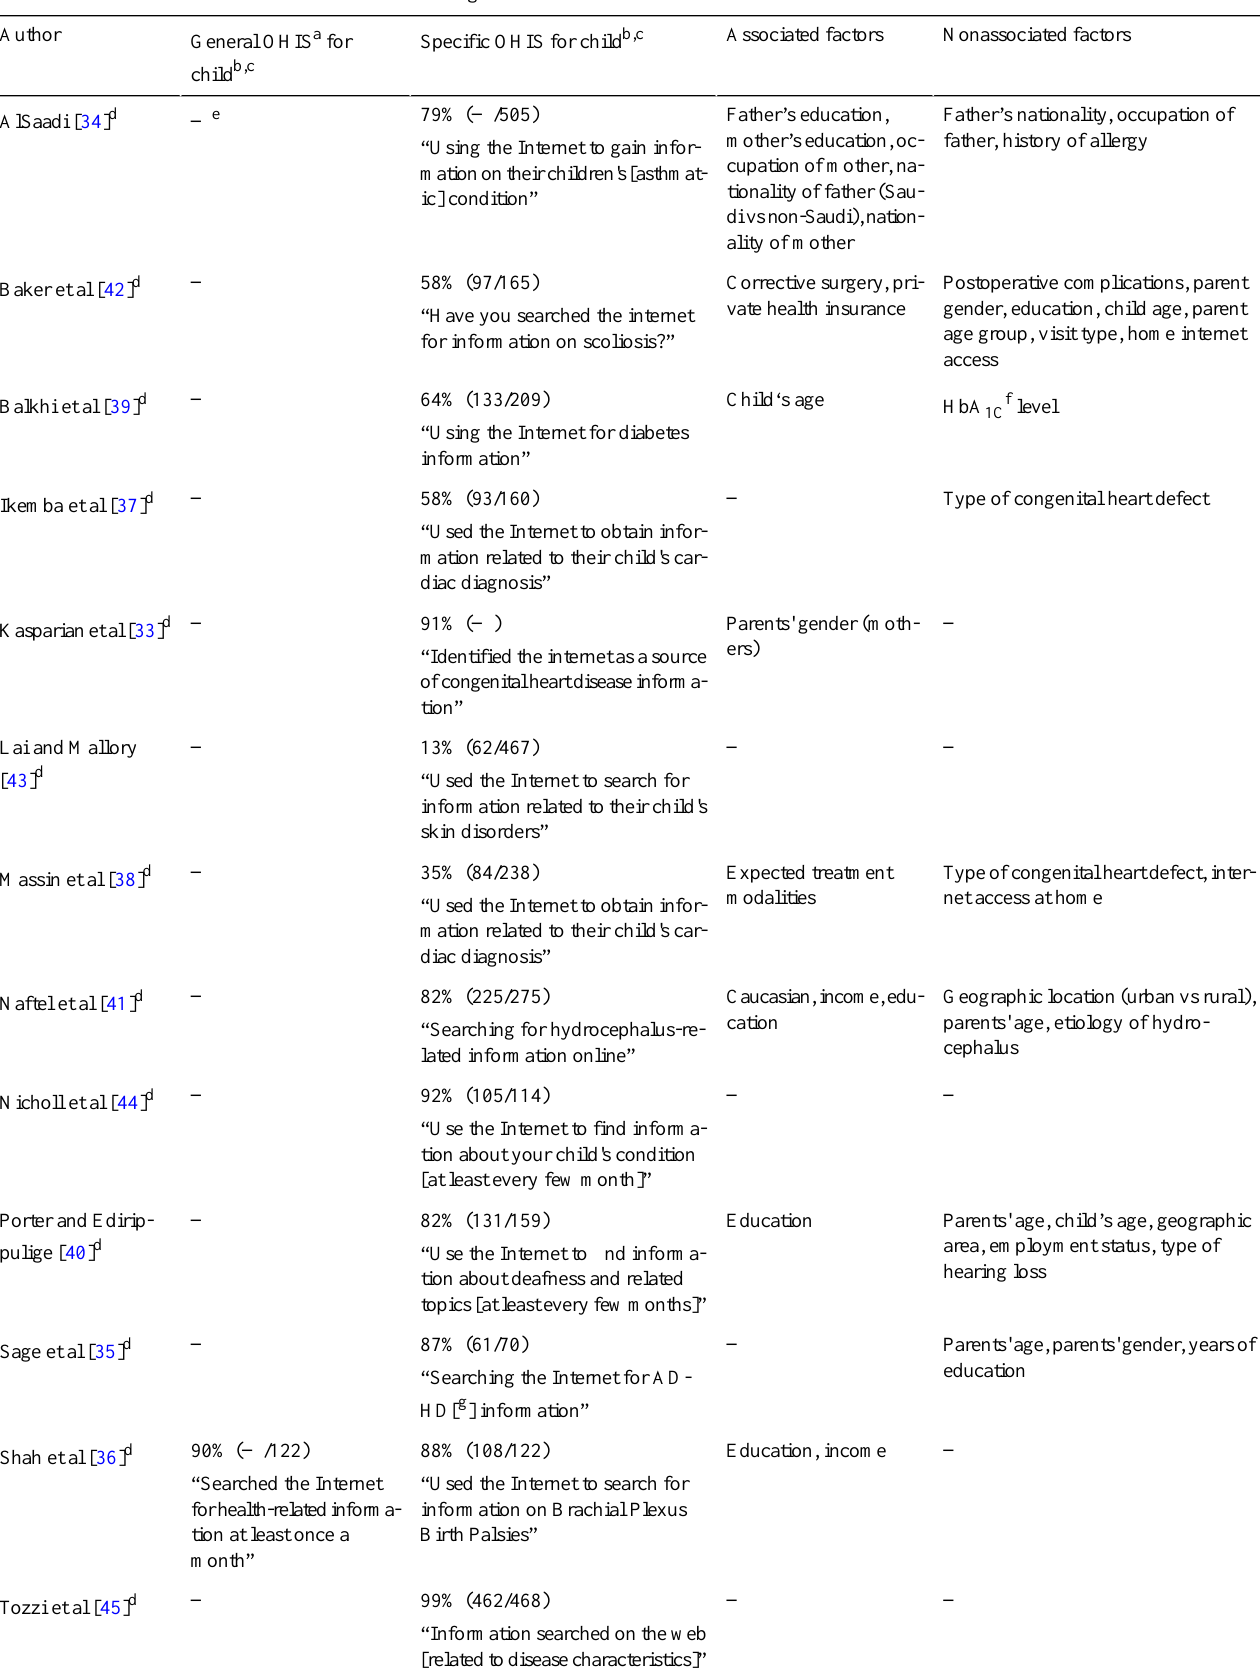
Table 3. Prevalence of online health information seeking and related